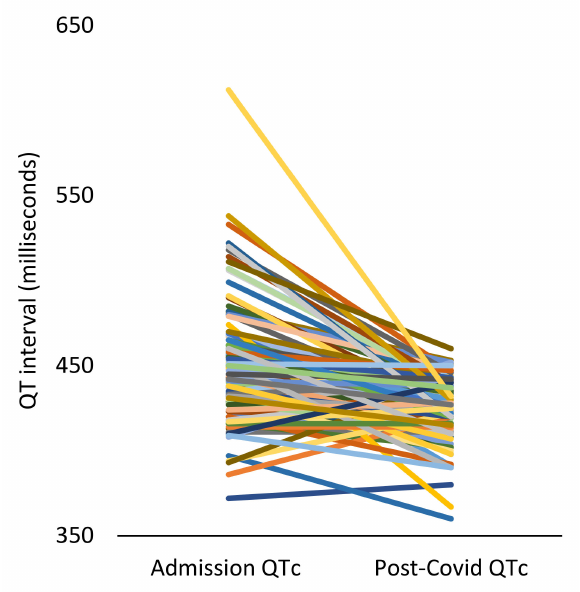
Figure 1. The QTc on admission and in the post-COVID period. The QTc had corrected in the post-COVID period in comparison to the interval recorded on the COVID-19 admission ( p <